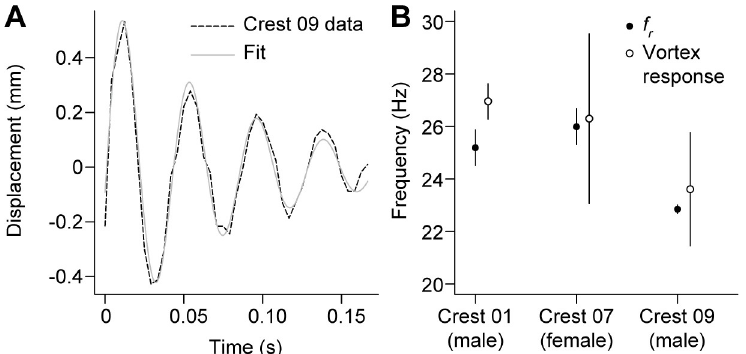
Fig 4. Displacement of the crest in response to air vortices. (A) Time series showing the change in flag position after a peacock crest (Crest 09) was impacted by a moving vortex of air. When peafowl crests were impacted by such air ring vortices, they deflected measurably, oscillating at their resonant frequency with an amplitude that decayed to a few percent of the initial value over the period of the peacock’s wing-shaking display. (B) Mean resonant frequencies ( f r ) and mean vortex response frequencies ( ± 95% CI) for three crests in the vortex